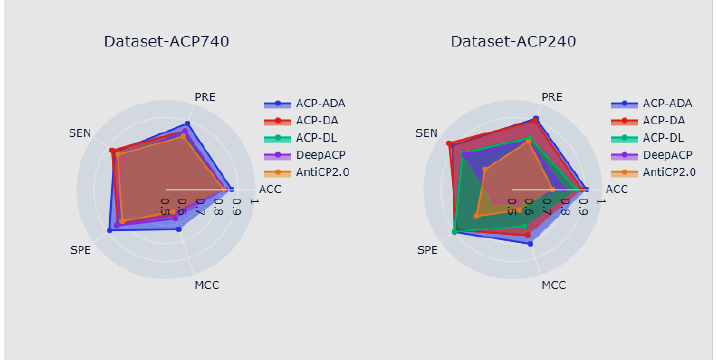
Figure 4. Comparison of ACP-ADA with existing methods on the ACP740 and ACP240